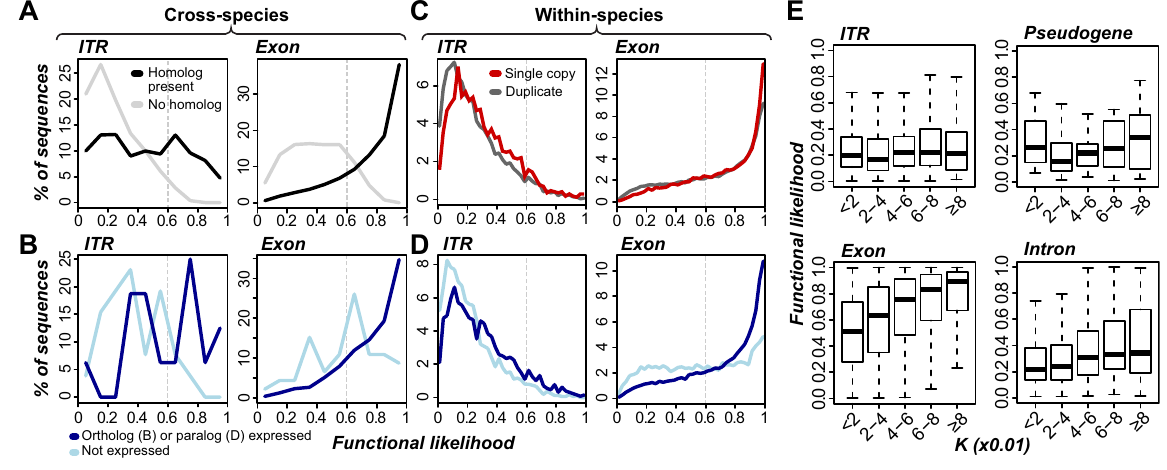
Figure 6. Relationships between functional likelihood scores and sequence/expression conservation characteristics. ( A ) Functional likelihood distributions for ITRs (left) and transcribed exons (right) with (black) or without (gray) cross-species homologs. ( B ) Functional likelihood distribution of ITRs (left) and transcribed exons (right) with syntenic orthologs that are expressed (blue) or not (cyan). ( C ) Functional likelihood distributions of ITR (left) and transcribed exons (right) that are single copy (red) or duplicated (dark gray). ( D ) Functional likelihood distribution of ITRs (left) and transcribed exons (right) with duplicates that are expressed (blue) or not (cyan). Vertical dotted line = T 1 . ( E ) Boxplots of the relationship between functional likelihood and nucleotide substitution rate for ITRs (top left), transcribed pseudogenes (top right), transcribed exons (bottom left) and transcribed introns (bottom